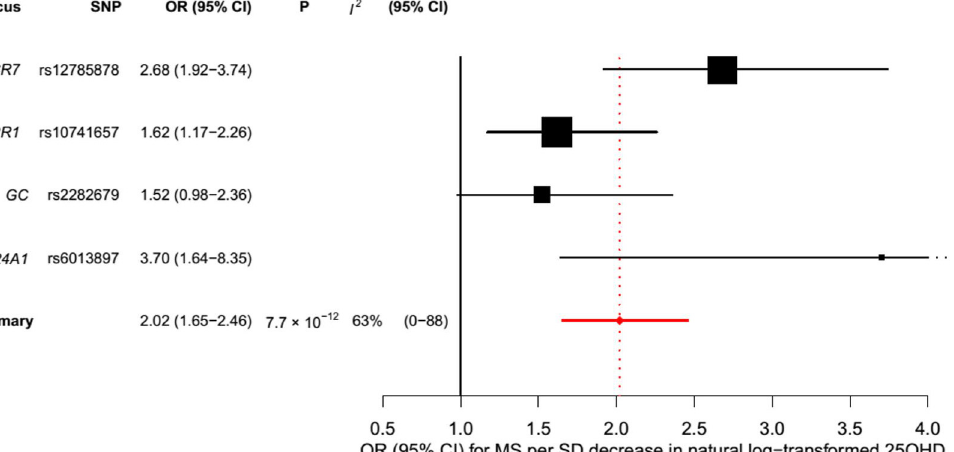
Fig 4. Mendelian randomization estimate of the association of 25OHD level with risk of multiple sclerosis. Estimates obtained using a fixed-effects